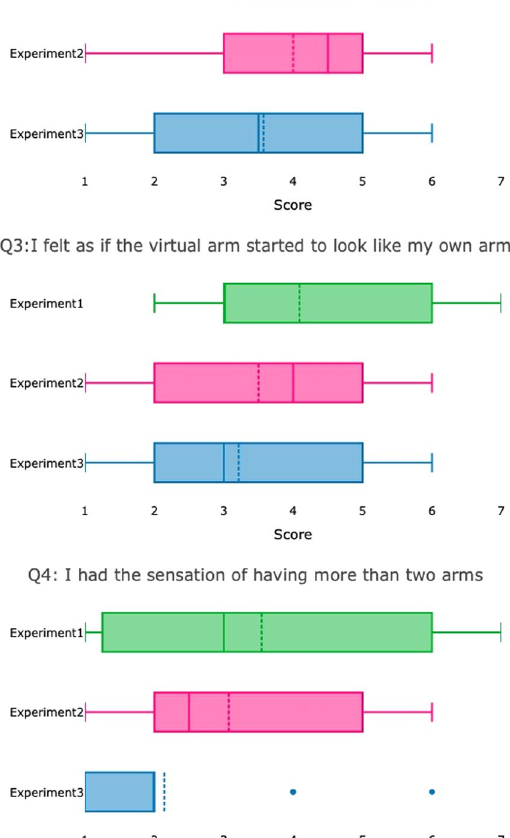
Figure 4. Participants’ mean (dotted line) responses to the questionnaire about ownership of the VR hand for the three experiments. The lines within each box represent the first interquartile, the median and the third interquartile. Whiskers represent the minimum and maximum; dotted lines represent the mean and SD. The plots were created using